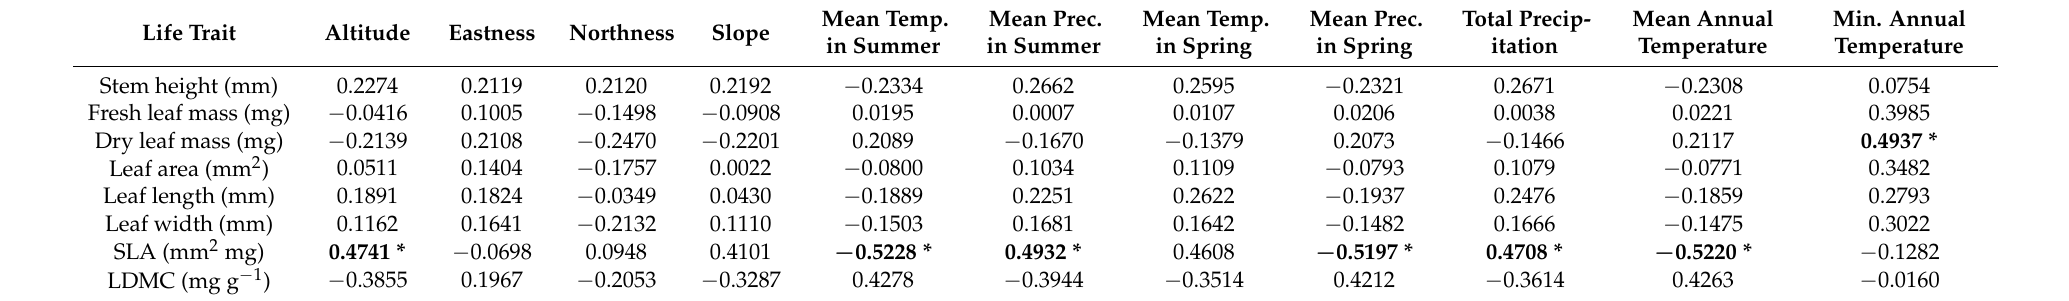
Table 5. Pearson correlation coefficients of E. annuus life traits with environmental variables: altitude, eastness, northness, slope, mean summer temperature, mean summer precipitation, mean spring precipitation, mean spring temperature, total annual precipitation, mean annual temperature, and minimum annual temperature. Bold values with asterisks indicate statistically significant correlations ( p <